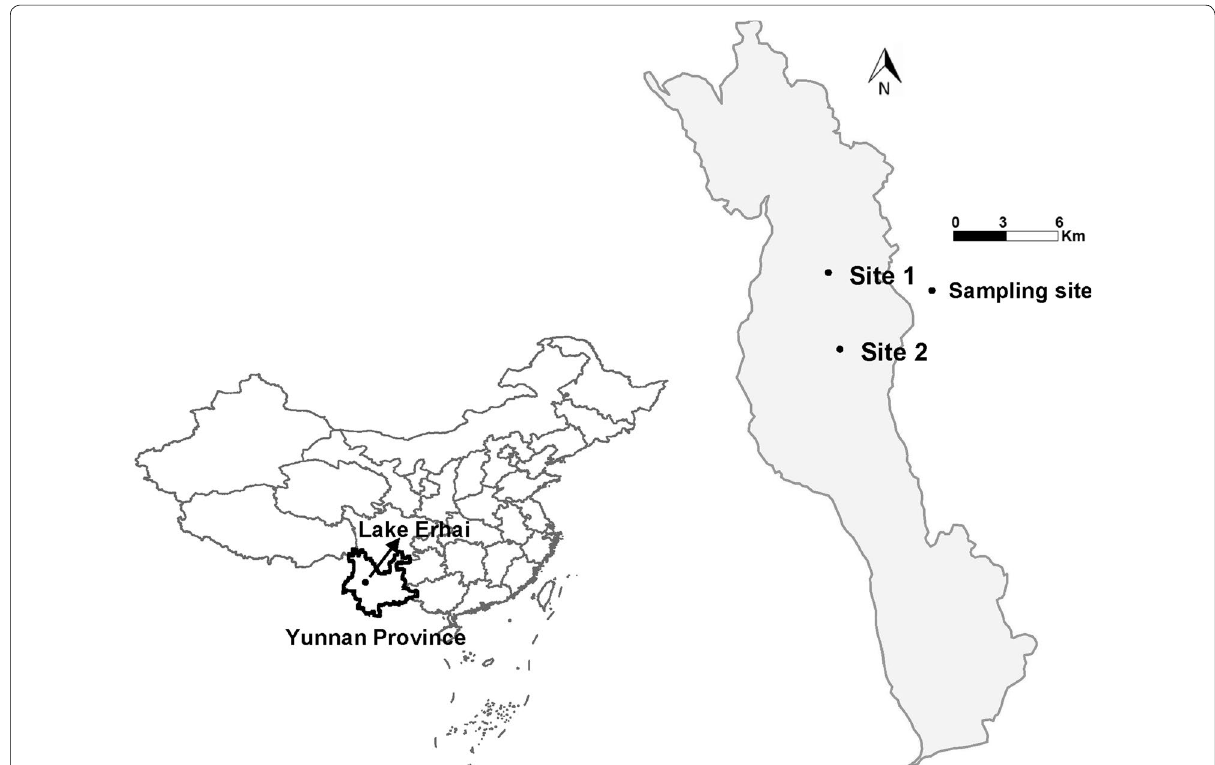
Fig. 1 A map of Lake Erhai with the locations of the sampling